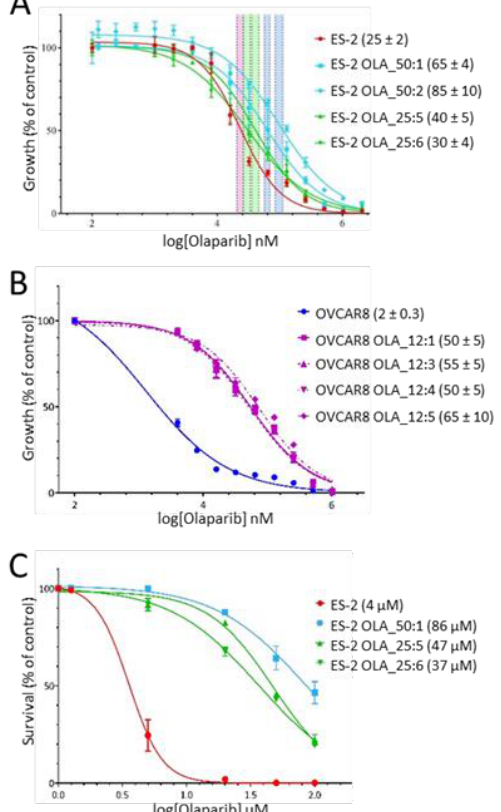
Figure 2. Decreased sensitivity of olaparib-resistant clones to olaparib. ( A ) Five-day growth assay for four ES-2 clones resistant to 25 or 50 µM olaparib. ES-2 parent is shown in red, 25 µM clones are in green, and 50 µM clones are in blue. IC50 values for each cell line (µM ± SEM) are shown in parentheses. 95% confidence intervals for IC50 values are shown as colored vertical bars. ( B ) Five-day growth assay for four OVCAR8 clones resistant to 12 µM olaparib. OVCAR8 parent is shown in blue, resistant clones are in pink. IC50 values (µM ± SEM) are shown in parentheses. ( C ) Eleven-day survival assay for three of the ES-2 clones shown in the growth assay above. ES-2 parent in red, 25 µM clones in green, 50 µM clone in blue. IC50 values (µM) are shown in parentheses.